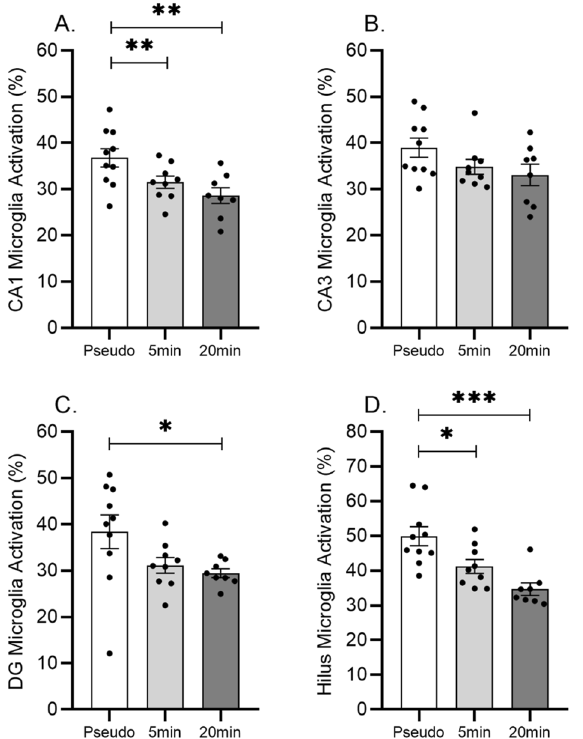
Figure 6. Effects of 5 and 20 min daily sessions of WBV on microglia activity in the subregions of dorsal hippocampus including CA1 (panel A ), CA3 (panel B ), Dentate gyrus innerblade (Panel C ) and Hilus regions (Panel D ). Data are depicted as mean ± SEM. * indicates P < .05; ** P < .001; *** P <